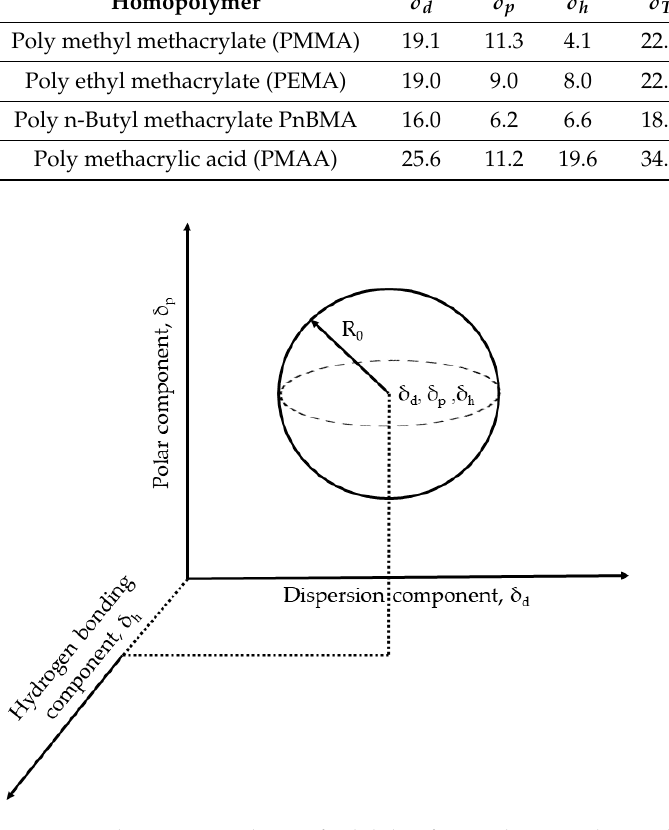
Figure 13. The Hansen volume of solubility for a polymer is depicted using a 3-D model of solubility sphere with center at ( δ d , δ p , δ h ) and radius of interaction ( R 0 ). Liquids whose parameters lie within